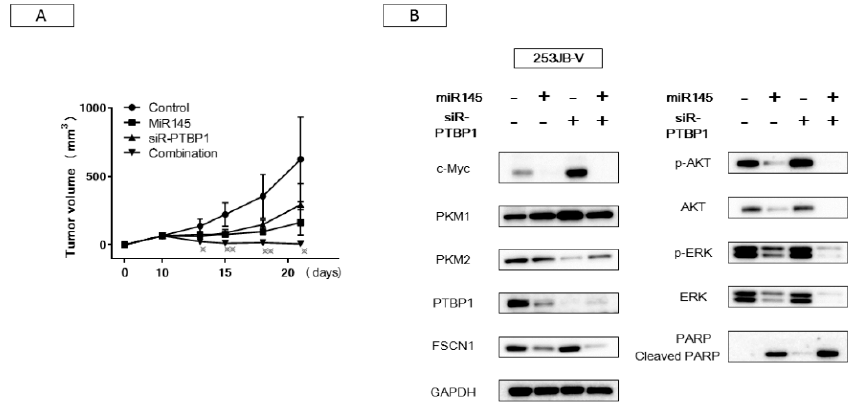
Figure 7. Antitumor effect of miR-145 or/and siR-PTBP1 on 253JB-V cells xenografted tumors induced in nude mice. ( A ) The graph shows time-course of tumor size in mice injected with each treatment. * indicated the significant in the tumor sizes in combination injection compared with each single-injection. ( B ) Expression levels of growth and Warburg effect-related proteins in each tumor tissue examined by Western blot analysis. * indicates p < 0.05; ** p < 0.01.